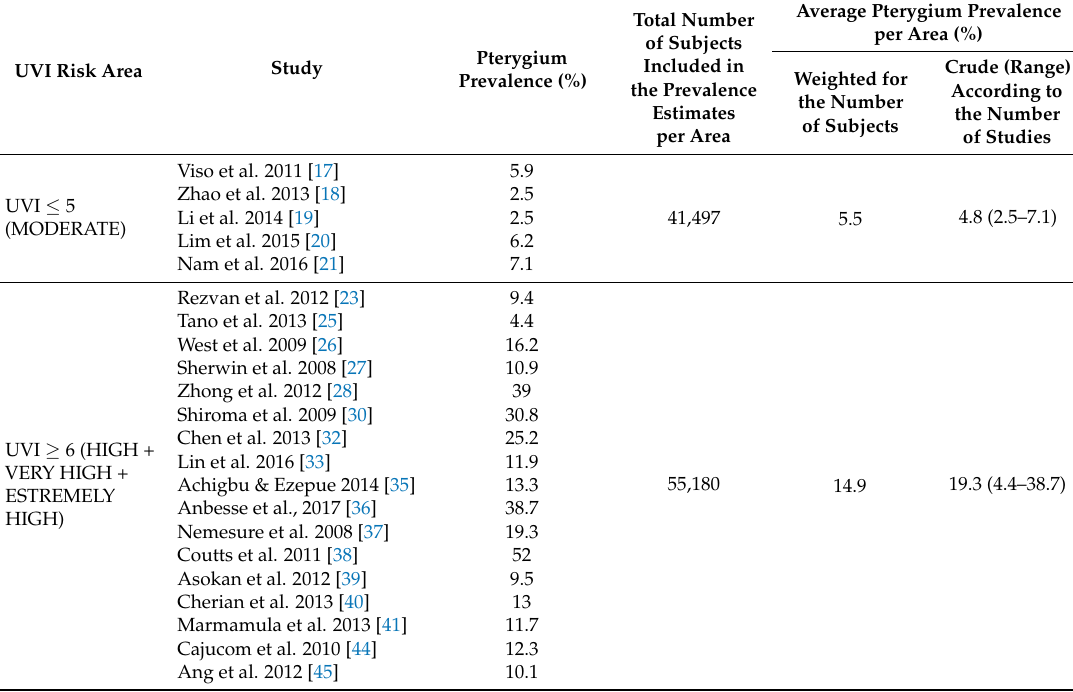
Table 6. Mean pterygium prevalence in the studies reviewed according to the UV risk areas: evaluation of the